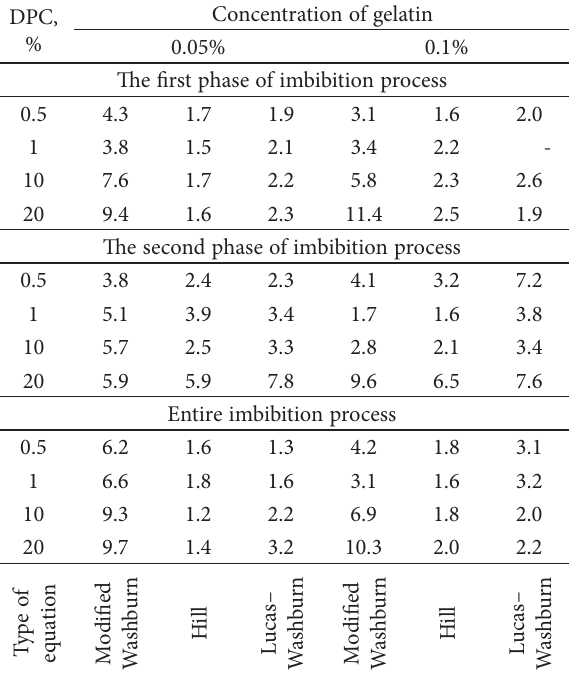
Table 6. The values of the normalized root mean square error for applied